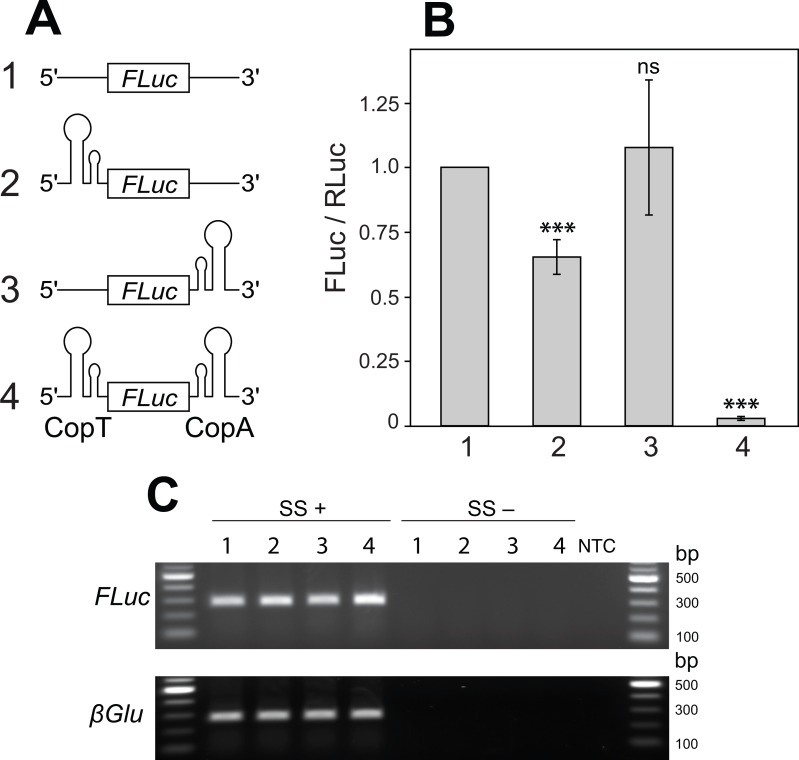
Two mRNA complementary hairpin structures (CopT and CopA) flanking a coding sequence block its translation.(A) No hairpin (1), one (2 and 3) or both hairpin structures (4) were inserted into the 5′ and 3′ UTRs of FLuc transcripts, as illustrated. (B) CopT hairpin inserted in the 5′ UTRs significantly decreased FLuc expression (2). Addition of CopA into the 3′ UTRs caused a further drop in the amount of FLuc (4), whereas a single CopA in the 3′ UTRs had no effect (3). Bars depict mean ± one standard deviation (P > 0.05 (ns), p < 0.01∗∗, P < 0.001∗∗∗). (C) Insertion of one or both hairpin structures did not affect abundances of FLuc and βGlu transcripts. SuperScript™ III reverse transcriptase was either added (SS+) or not added (SS−) to RT reactions. No template was added to the last well (NTC).